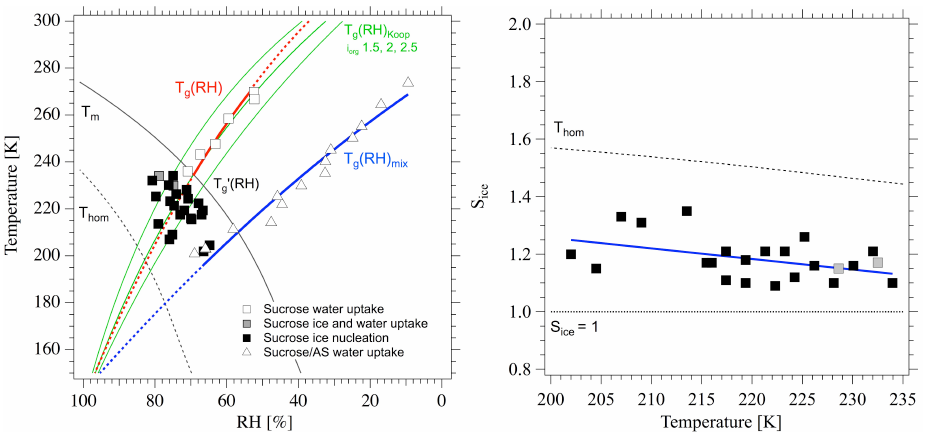
Fig. 2. State diagram for sucrose constructed using experimental data (left panel). T g (RH) (red) and T g (RH) mix (blue) lines were created by fitting polynomial curves to experimental water uptake data. Green lines represent the theoretical RH dependence of T g estimated following the method of Koop et al. (2011). T g (dry) = 335.7 K and k GT = 4 . 86 were used to calculate T g (RH) Koop for van’t Hoff factors ( i org ) 1.5, 2 and 2.5. T m is the ice melting curve and indicates where S ice = 1. Black markers represent experiments in which depositional ice nucleation was observed without water uptake. For experiments indicated by gray markers, ice nucleation was observed on one particle while liquid water was detected on other particles within the same field of view. The right panel gives ice saturation ratios as a function of temperature for each of the experiments in which ice nucleation was observed. T hom in both figures indicates where homogeneous ice nucleation would occur in liquid particles according to the parameterization of Koop et al. (2000) assuming a homogeneous ice nucleation rate of 5 × 10 9 cm − 3 s − 1 . Fit parameters for experimental T g (RH) curves are given in Appendix A, Table A1.